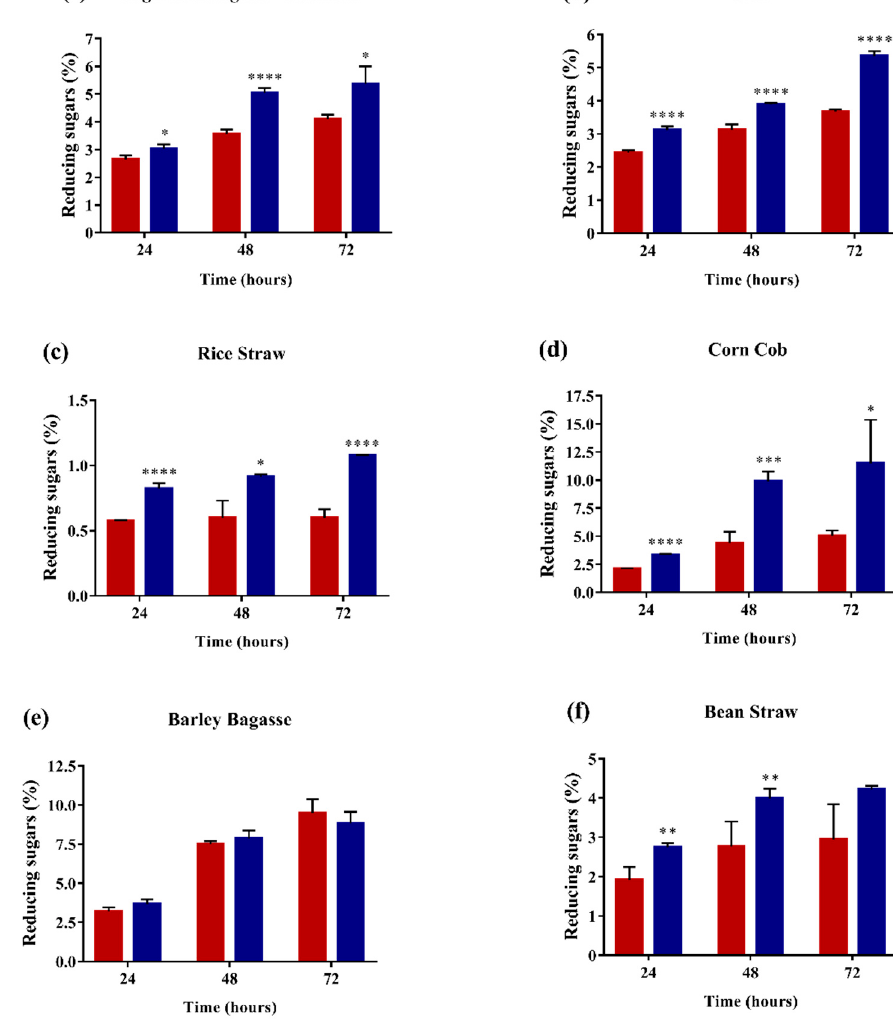
Figure 5. E ff ect of the cellulase cocktail Celluclast ® 1.5L (Red box) and supplemented by the addition of Af-EGL7 (Blue box), during hydrolysis of the agricultural residues ( a ) Sugarcane bagasse “in natura”, ( b ) SEB, ( c ) Rice straw, ( d ) Corn cob, ( e ) Barley bagasse and ( f ) Bean straw. The data represent means ± standard errors obtained from at least three experimental replicates.